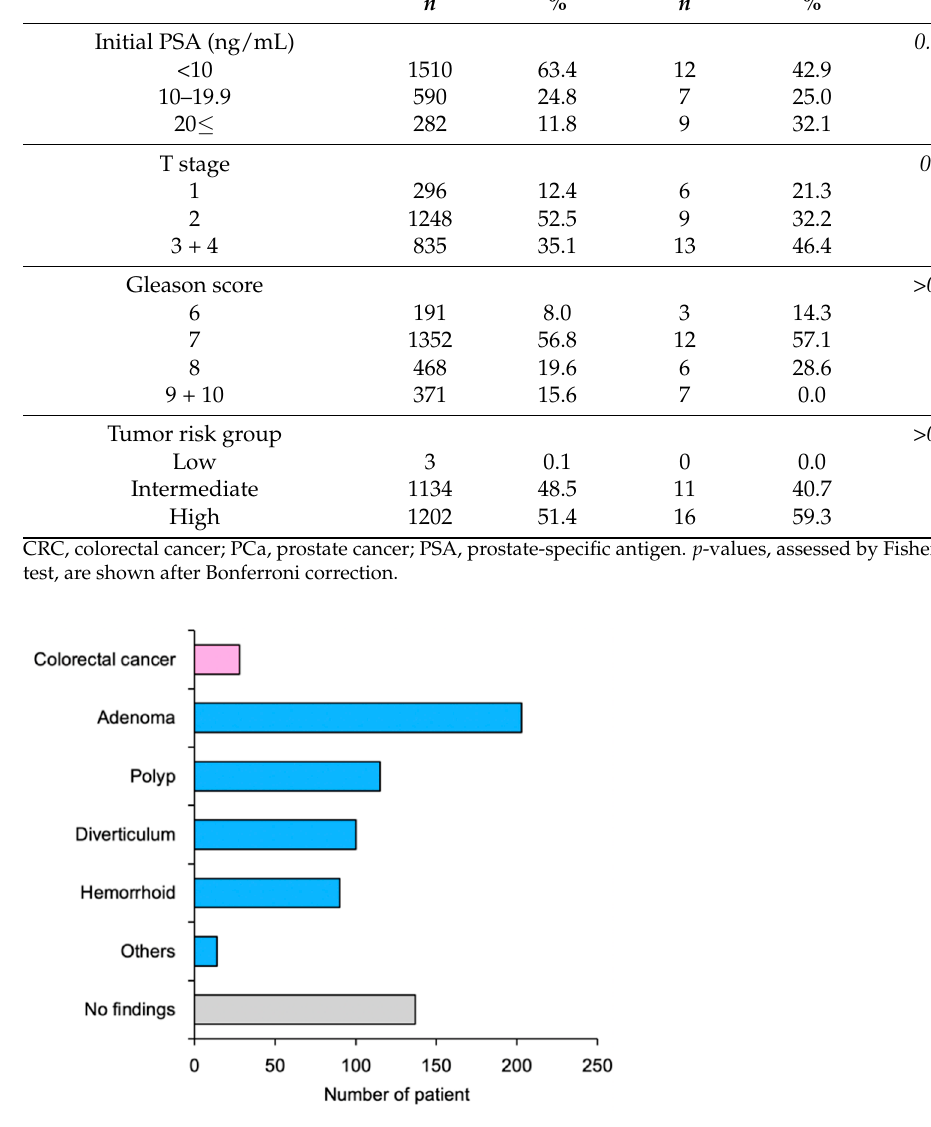
Figure 2. Colonoscopy findings among fecal immunochemical test-positive patients. See Section 2.2 for the definition of adenoma and polyp.